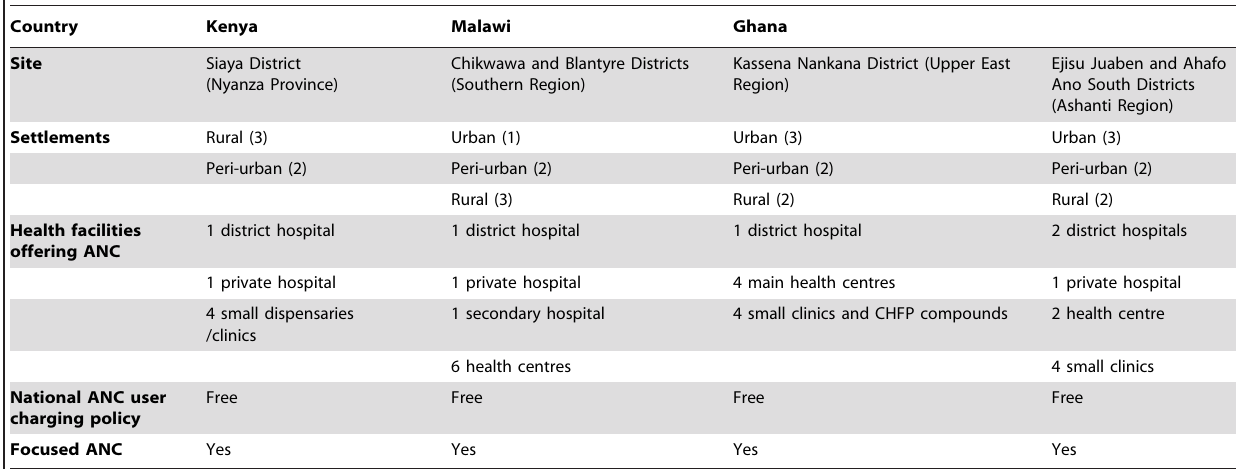
Table 3. The study